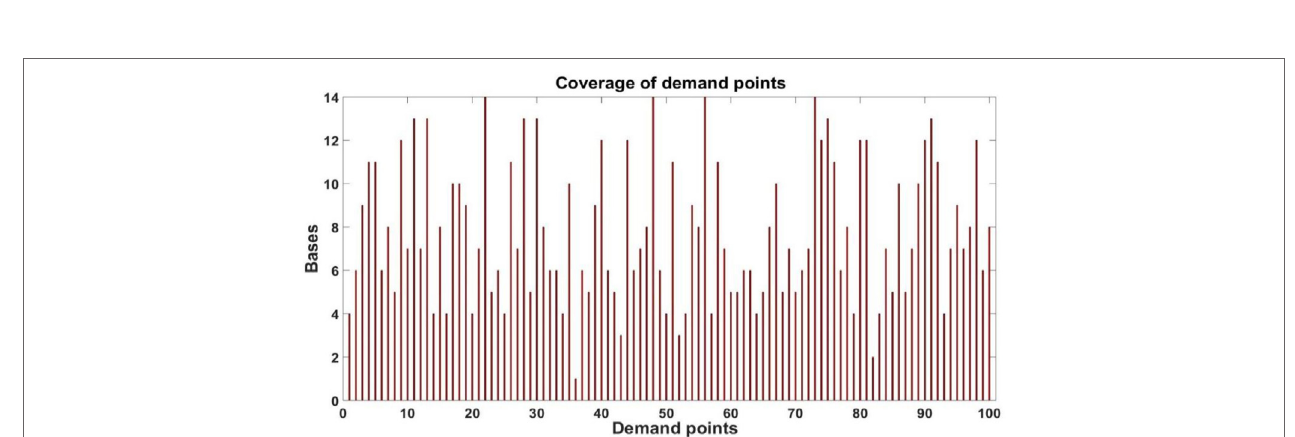
FigUre 15 | Number of bases covering demand